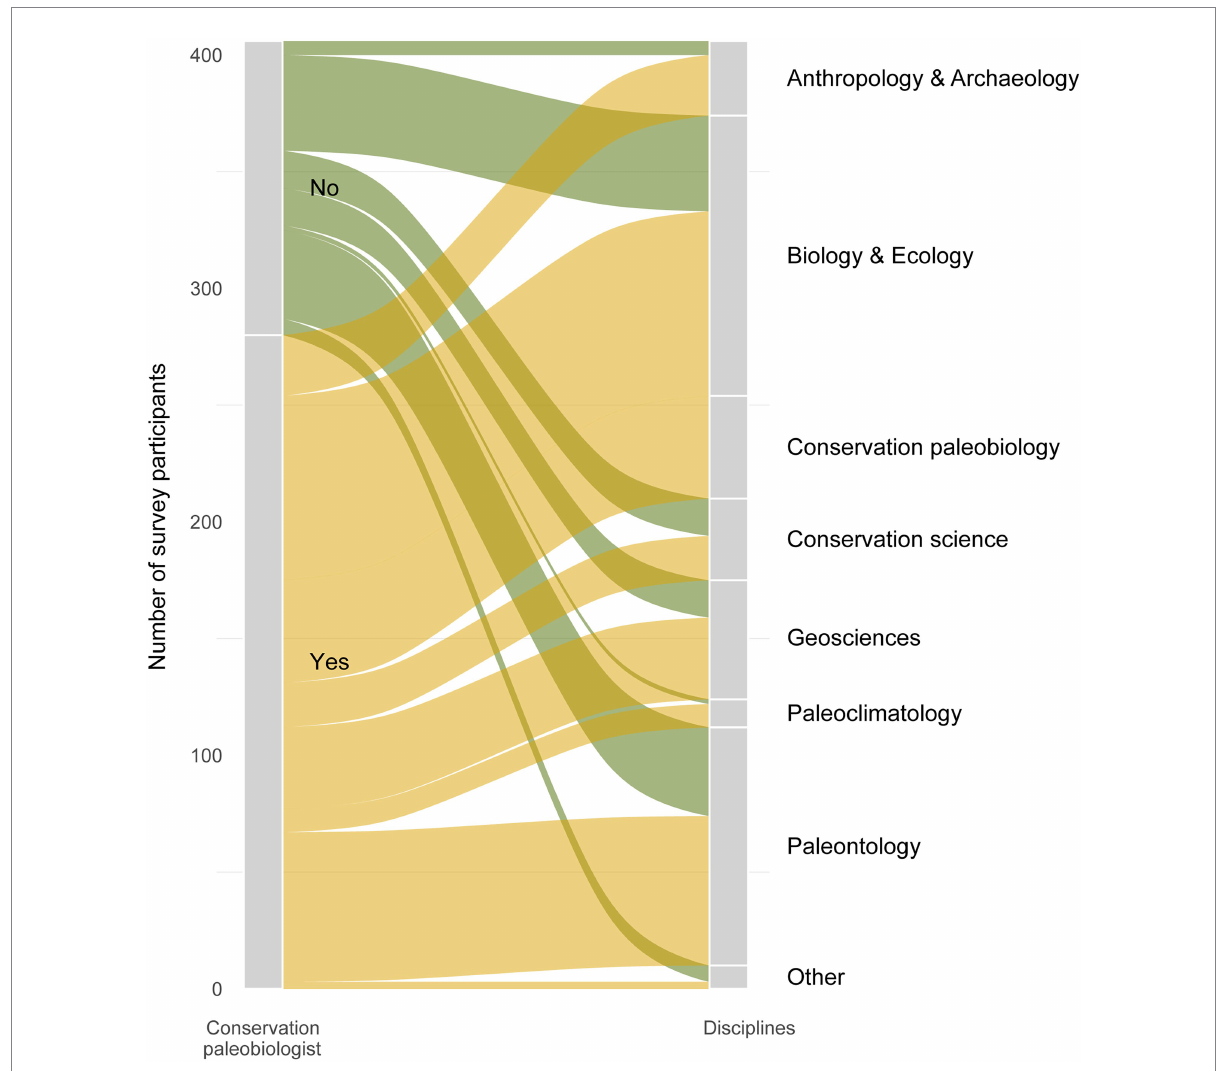
FIGURE 2 Disciplinary affiliations of survey participants who did (yellow) and did not (green) conduct work that they considered to be CPB. Participants were able to select up to three disciplines to describe their expertise. Disciplines were grouped to facilitate visualization (see Supplementary methods for the grouping methodology). Disciplinary affiliations overlapped between these two groups of